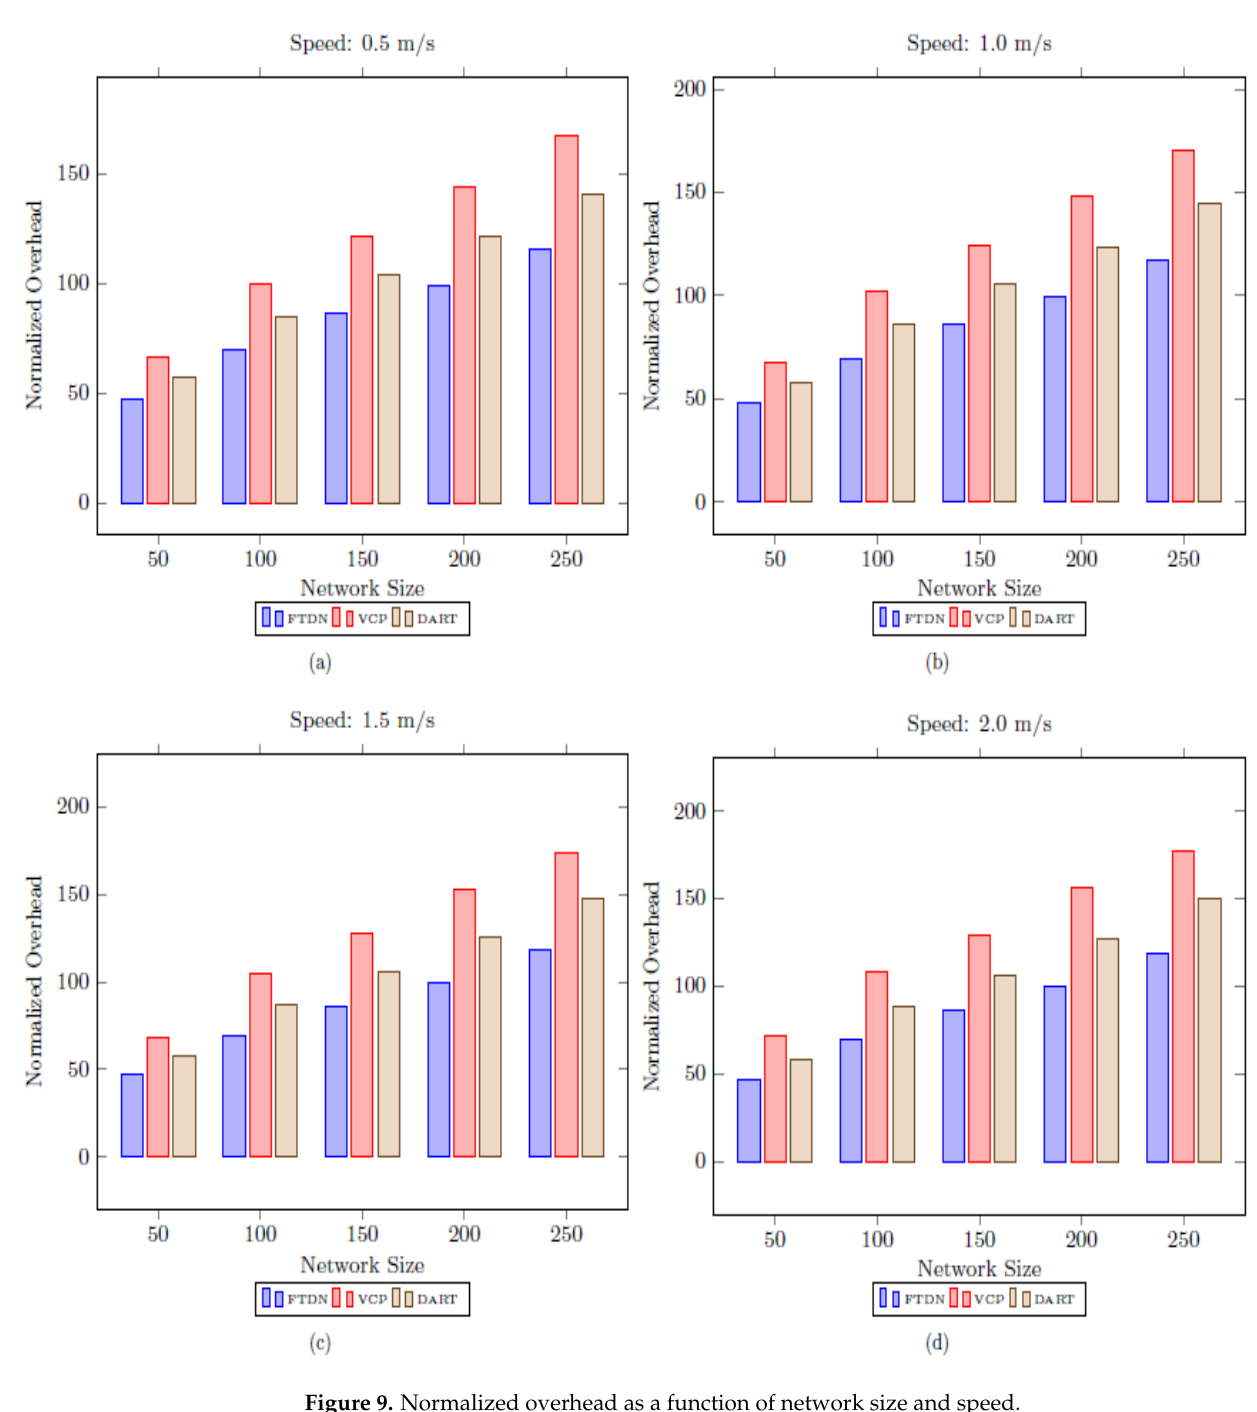
Figure 9. Normalized overhead as a function of network size and speed. Boxplot analysis comparison, with varying network sizes and speed, shown in Figure 10, shows consistent gains in FTDN as compared to VCP and